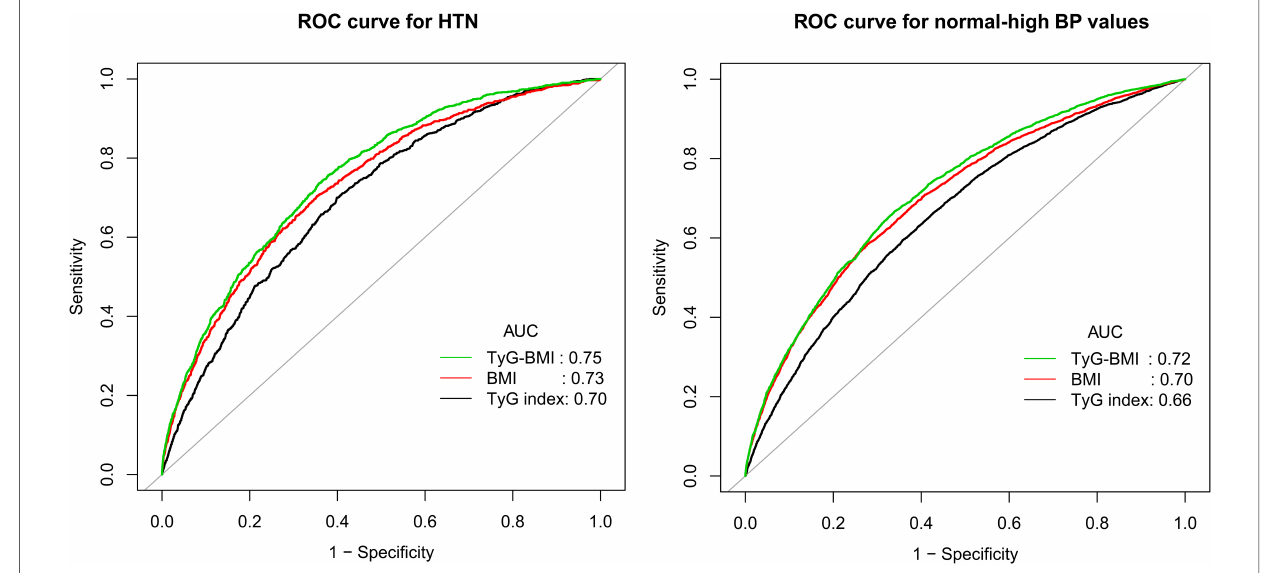
FIGURE 3 Receiver operating characteristic curve analyzes the value of BMI, TyG index and TyG-BMI in identifying HTN/normal-high BP values. BMI, body mass index; TyG index, triglyceride-glucose index; TyG-BMI, triglyceride glucose-body mass index; AUC, the area under the curve; HTN, hypertension.